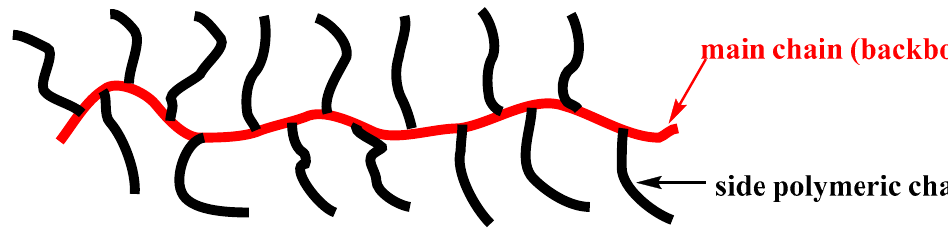
Figure 3. Molecular brush structure.